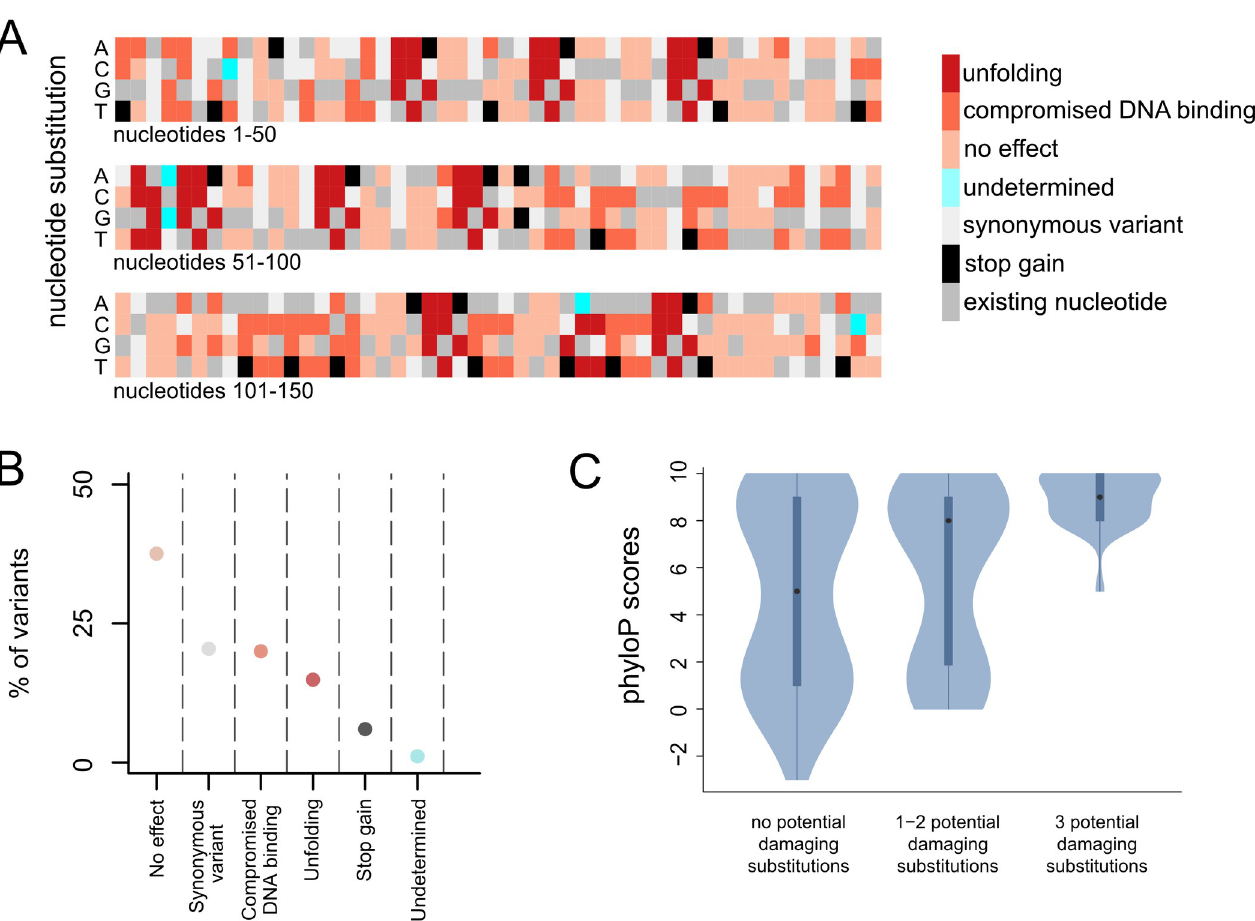
Fig 4. An in silico saturation mutagenesis of the CXXC domain of KMT2A . (A) Heatmap depicting the predicted effect of each nucleotide substitution within the CXXC domain. (B) The percentage of variants for each type of predicted effect. (C) The distribution of the phyloP score of the nucleotides coding for the CXXC domain, stratified according to the number of substitutions predicted to have a damaging effect (unfolding, compromised DNA binding, stop-gain).